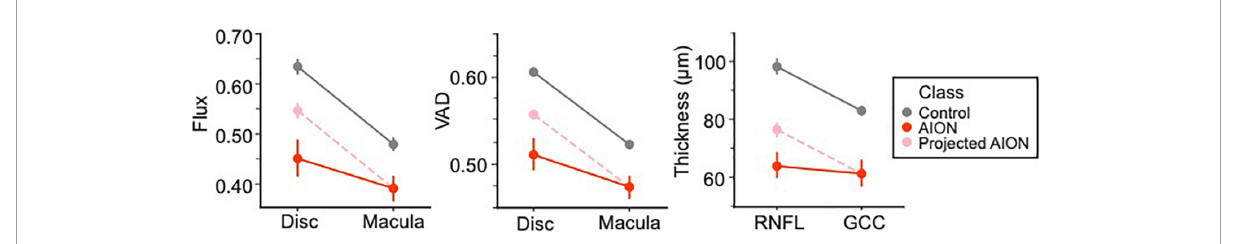
FIGURE6 ANOVA results differentiating control and chronic non-arteritic anterior ischemic optic neuropathy (NAION) patients. The results showed that chronic NAION patients’ peripapillary measurements [i.e., retinal nerve fiber layer (RNFL) thickness, disk vessel area density (VAD) and flux measurements] were lower than what we expect based on controls with the same macula values [ganglion cell complex (GCC) thickness, VAD and flux measurements for annulus masks]. We predict this is evidence for the peripapillary structure being “hit twice” in chronic